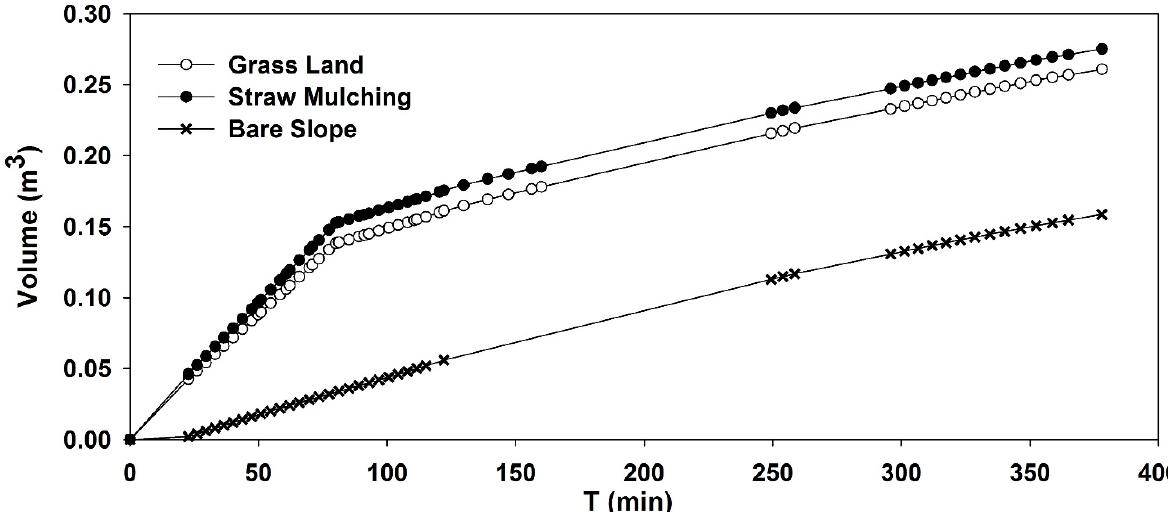
Figure 20. The time-series graphs of the accumulated groundwater volume under three